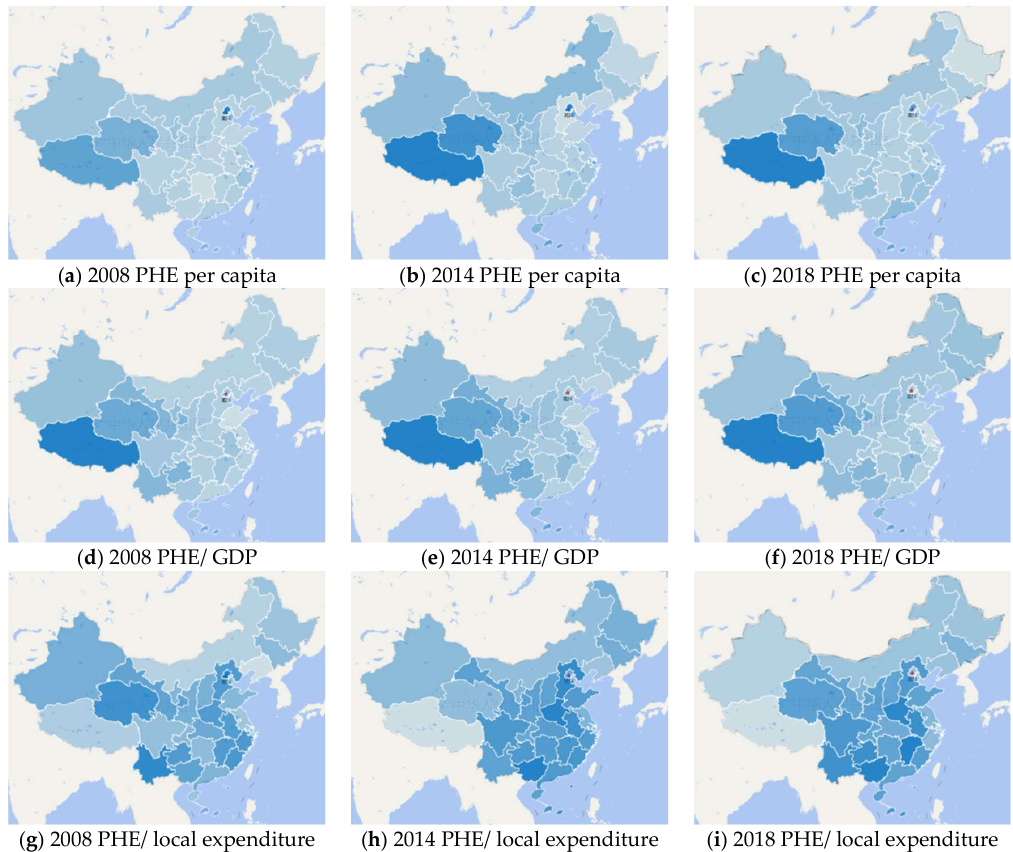
Figure 3. Geographical distribution of Chinese public-health expenditure. Note: PHE is short for public- health expenditure. Note: These figures above are made by the authors, and there is no copyright